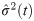
True and estimated variance path.The four graphs show the true variance, σ
2(t), (solid line) and the Fourier estimated variance, σ^2(t), (dotted line) as a function of time for four realizations obtained with model (11)–(12) and a sampling interval of 2 minutes.